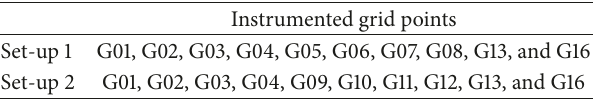
Table 3: Instrumental set-up for modal tests. Instrumented grid